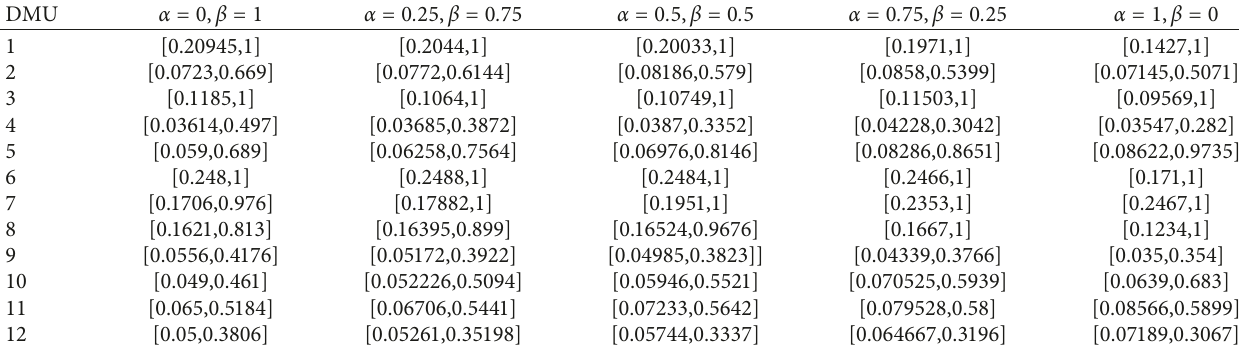
Table 4: Optimistic-pessimistic efficiency calculations of the first stage for different levels of α - β cuts.